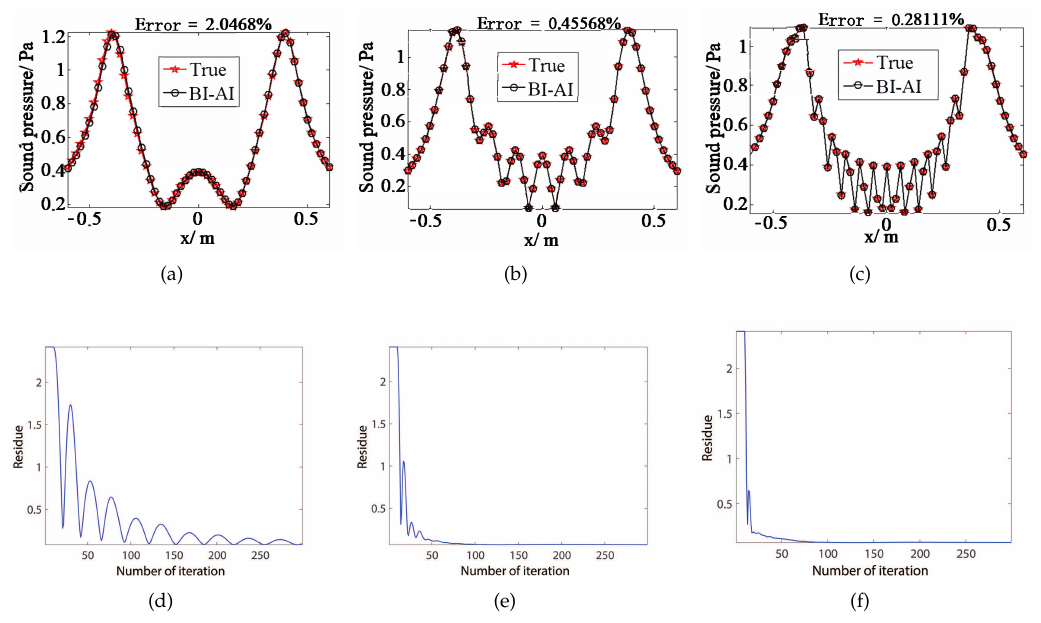
Figure 2. The sound field reconstruction with BI-AI at the frequencies of 500 Hz ( a , d ), 1500 Hz ( b , e ), and 3000 Hz ( c , f ). ( a – c ) are the reconstruction pressure along the x -axis.